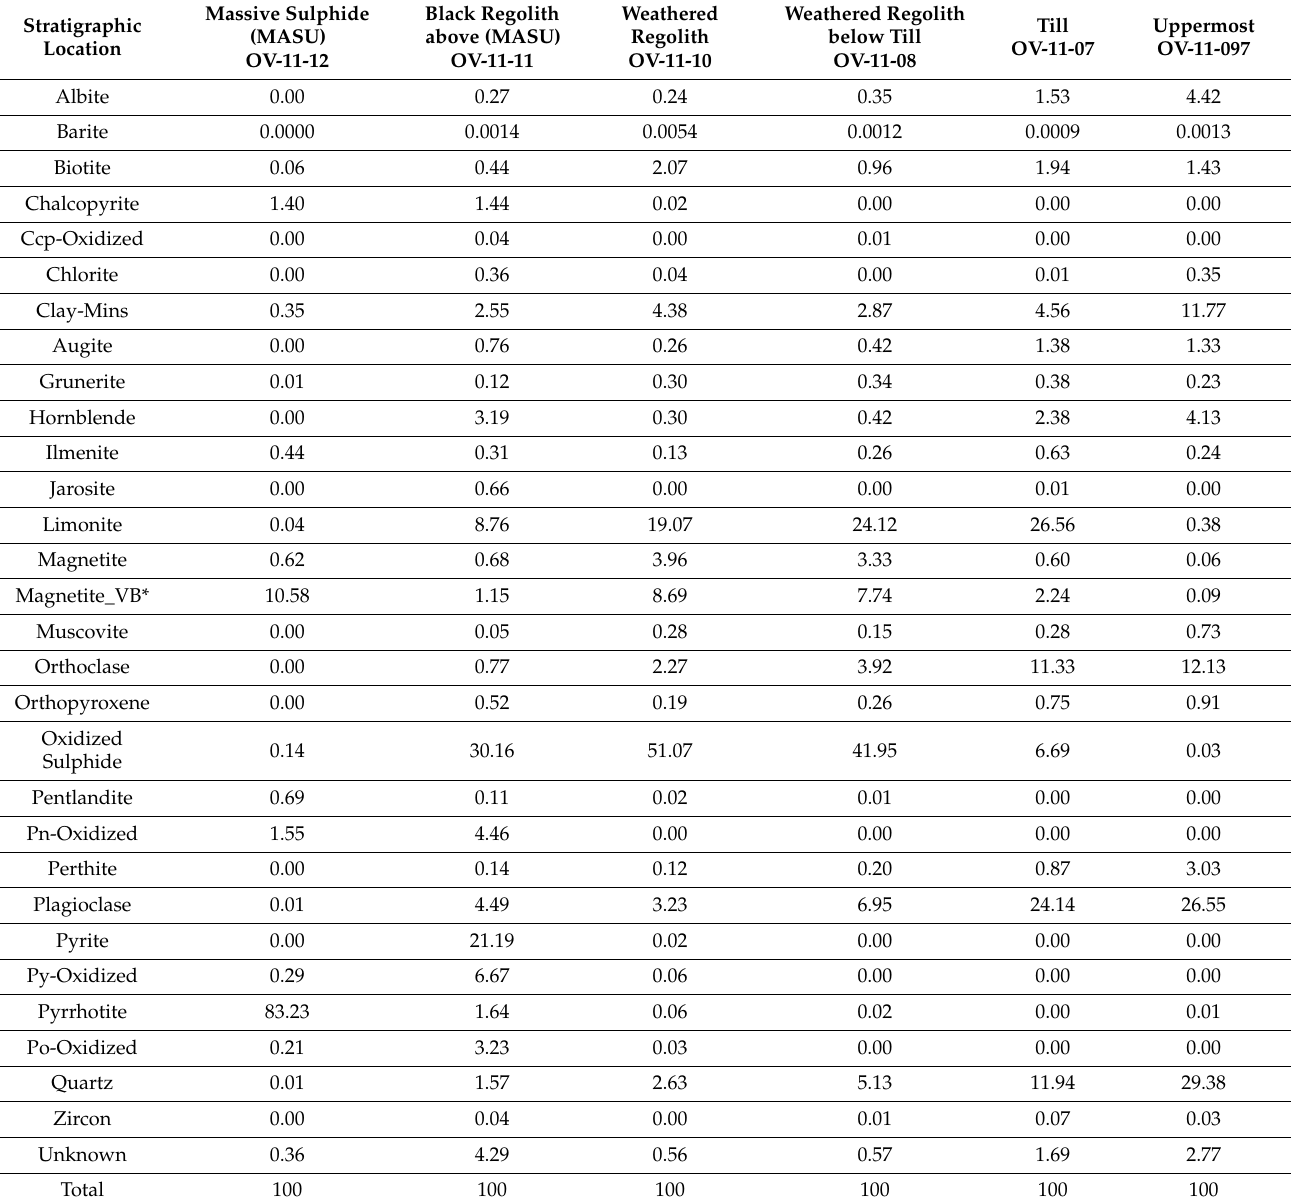
Table 3. MLA-defined mineral data (area %) for OV-11 samples—Mini-Ovoid, Voisey’s Bay (* Magnetite-VB is an EDX standard of Ti-rich magnetite from the Voisey’s Bay